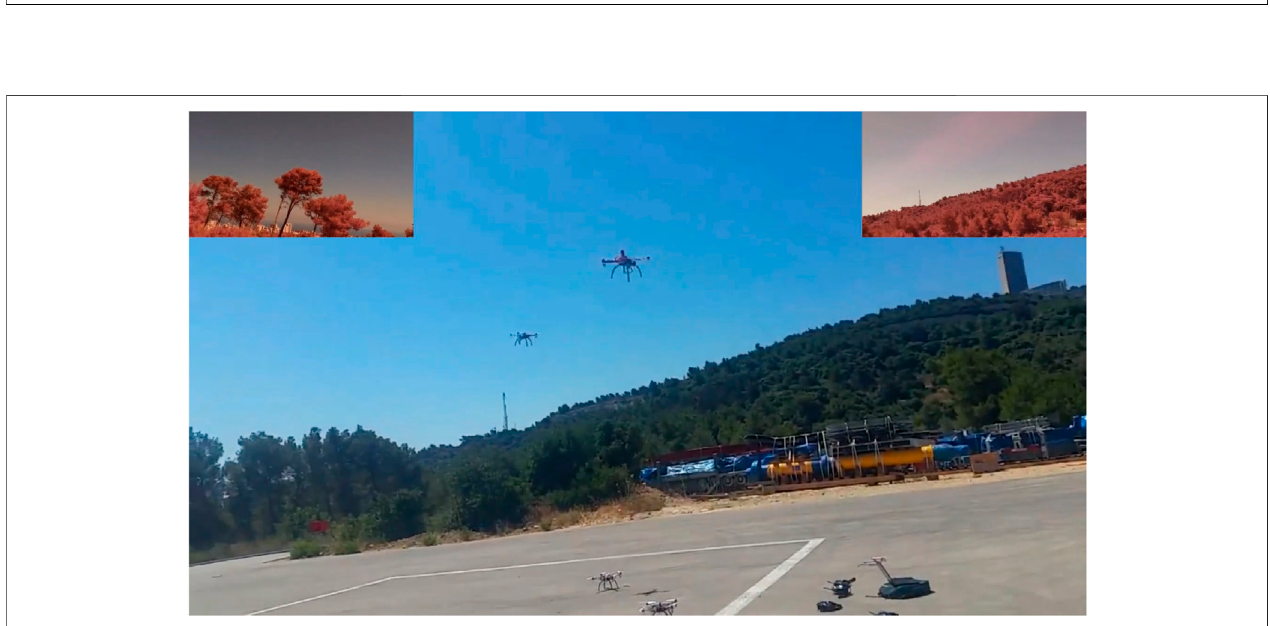
FIGURE 12 | AntAlate template application demonstrated with 470 mm quadcopters. Frames captured by the video capture behavior are presented in the upper corners.